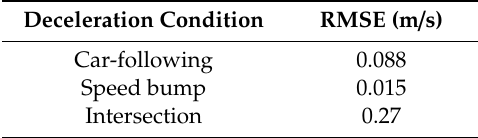
Table 5. Root-mean-square error (RMSE) of velocity in each sliced result.